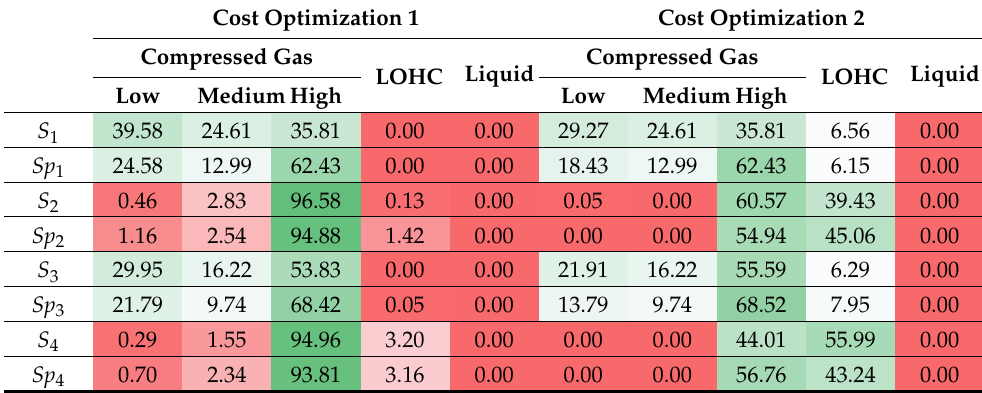
Table 8. Sensitivity analysis of the share of transport technology per transported